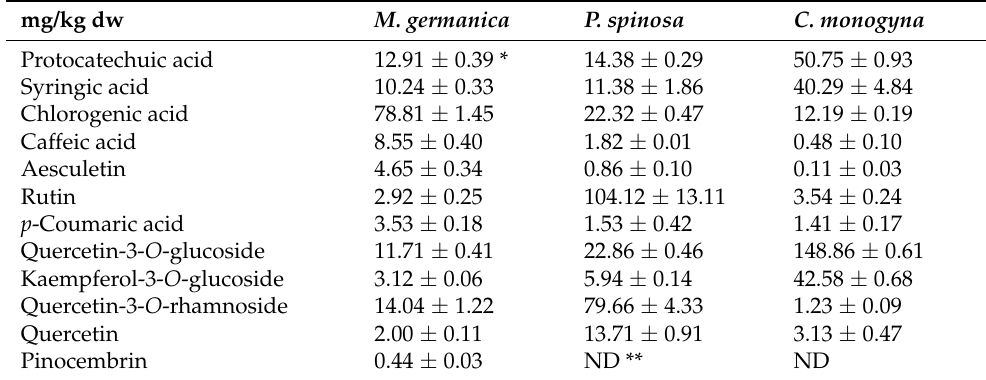
Table 2. UHPLC/( − )HESI–MS/MS quantitative analysis of phenolic compounds in M. germanica , P. spinosa and C. monogyna fruit ethanolic